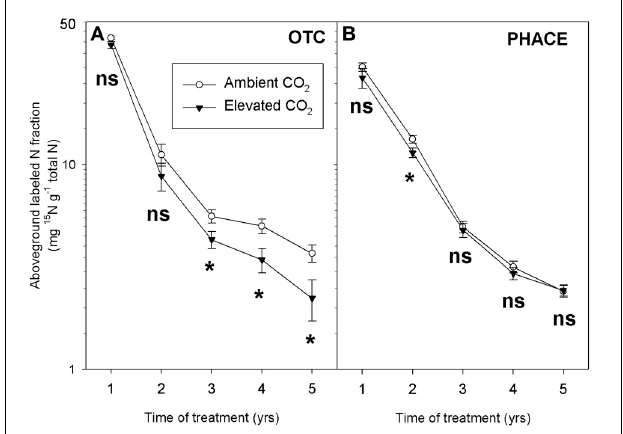
FIGURE 3 | Labeled N fractions (expressed per total amount of N) in aboveground biomass over time in the OTC (A) and PHACE (B) experiment. A 15 N label was added to the soil in the Spring of year 1 and aboveground biomass was sampled at peak biomass in July in the following 5 years. For each year, CO 2 treatment effects were tested with ANOVA (ns: not significant, ∗ P < 0 .